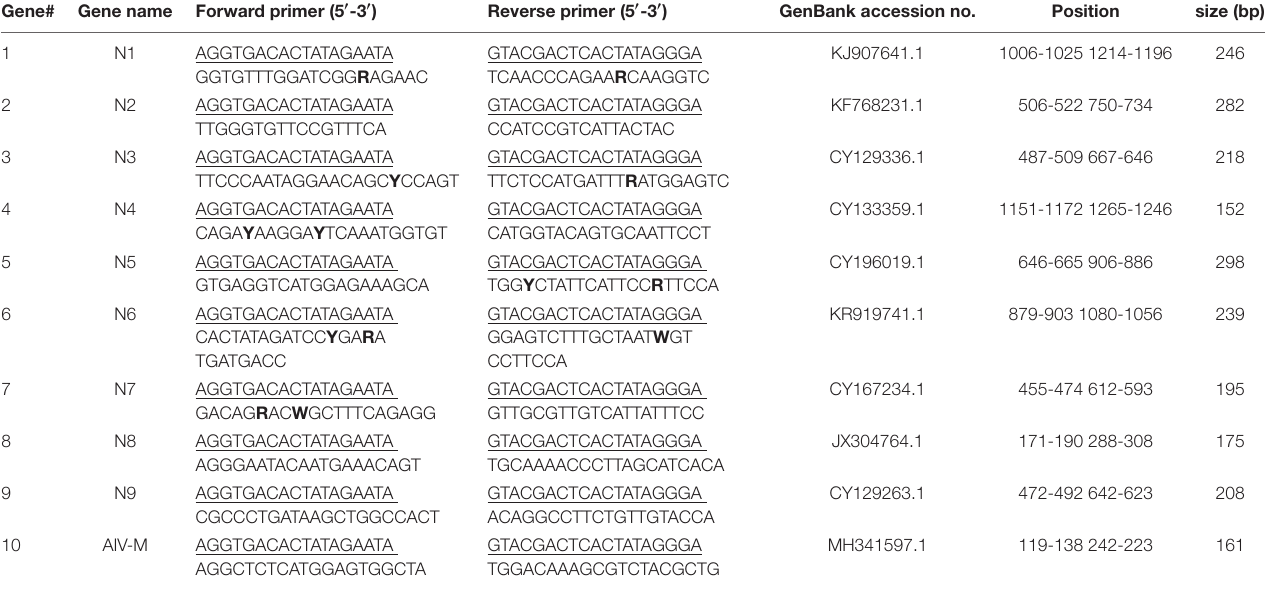
TABLE 1 | Primer information for the GeXP